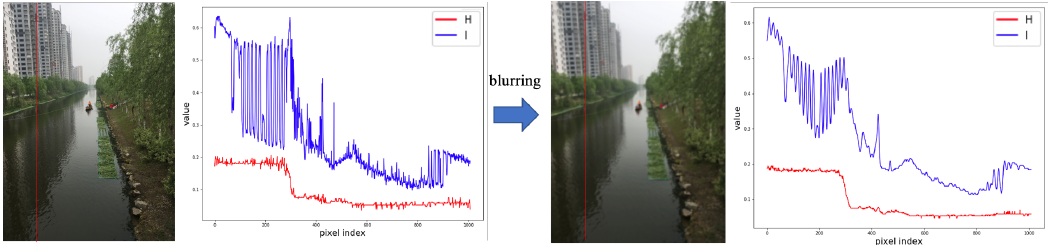
Figure 9. Pixel values before and after blurring